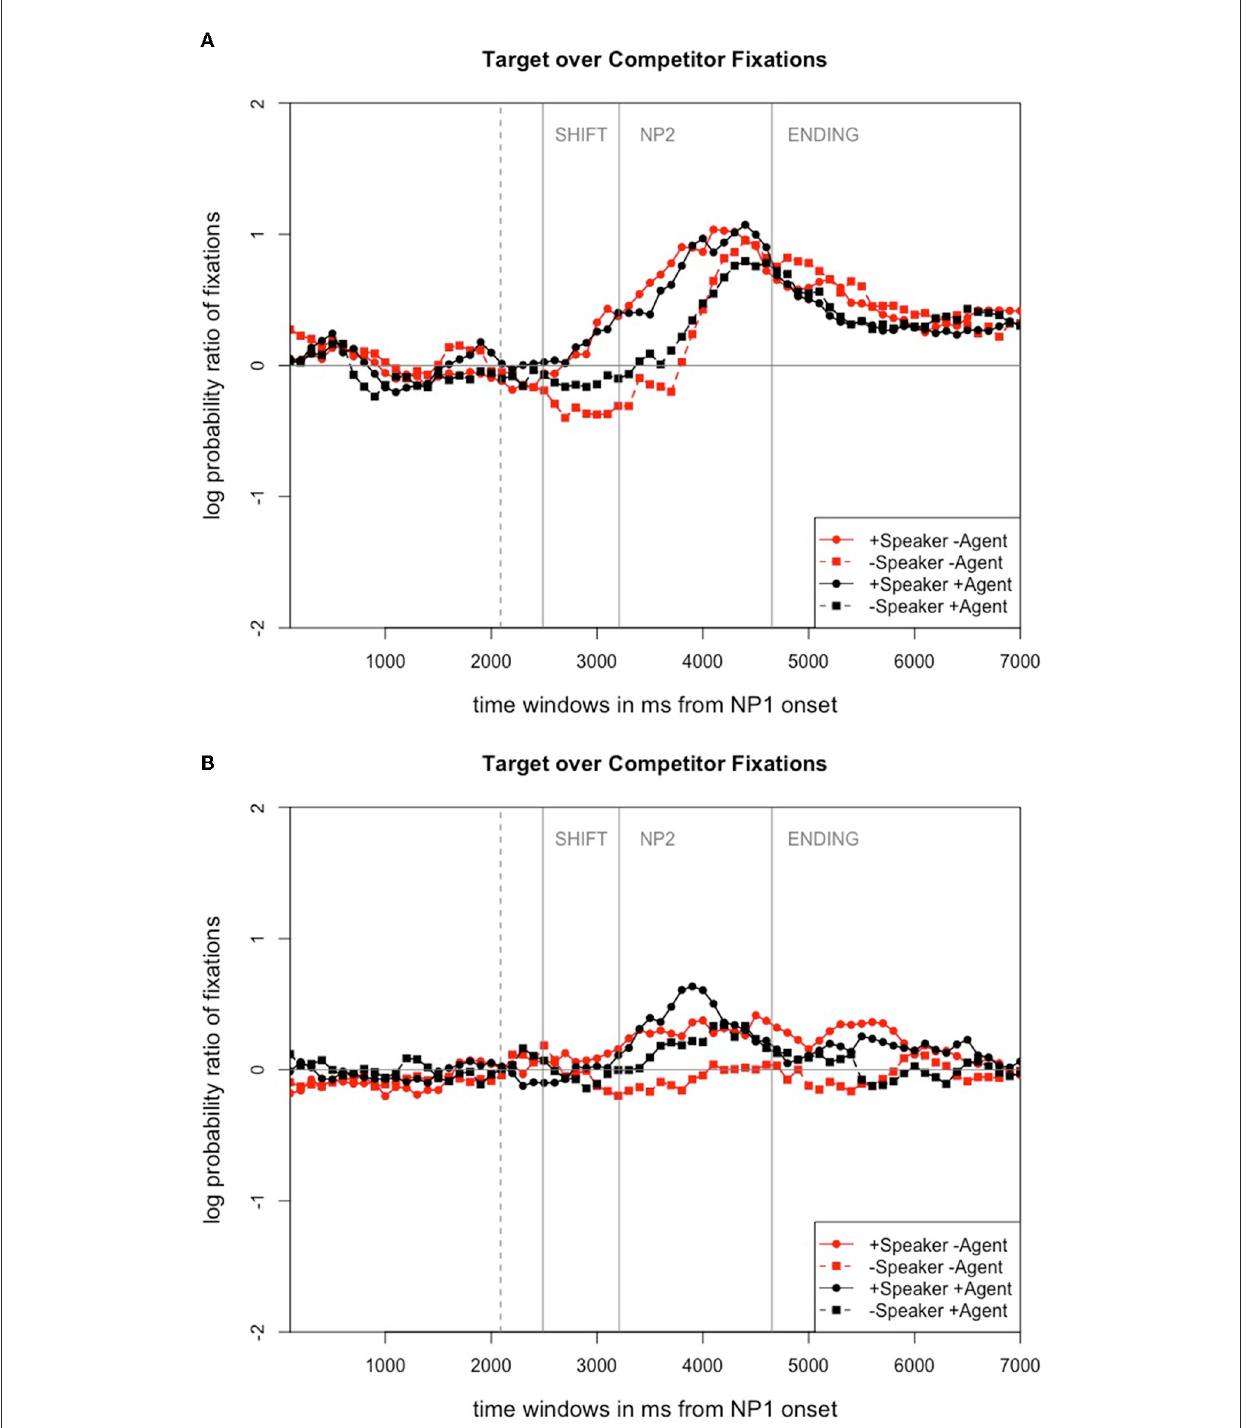
FIGURE5 Time course graphs (in ms ) from NP1 onset until ending offset for the experiments with altered agent listener gaze. The dotted gray line marks the earlier shift onset for the virtual agent. (A) Time course graph for Experiment 3. Adapted from Nunnemann (2021, p. 135). (B) Time course graph for Experiment 4. Adapted from Nunnemann (2021, p.